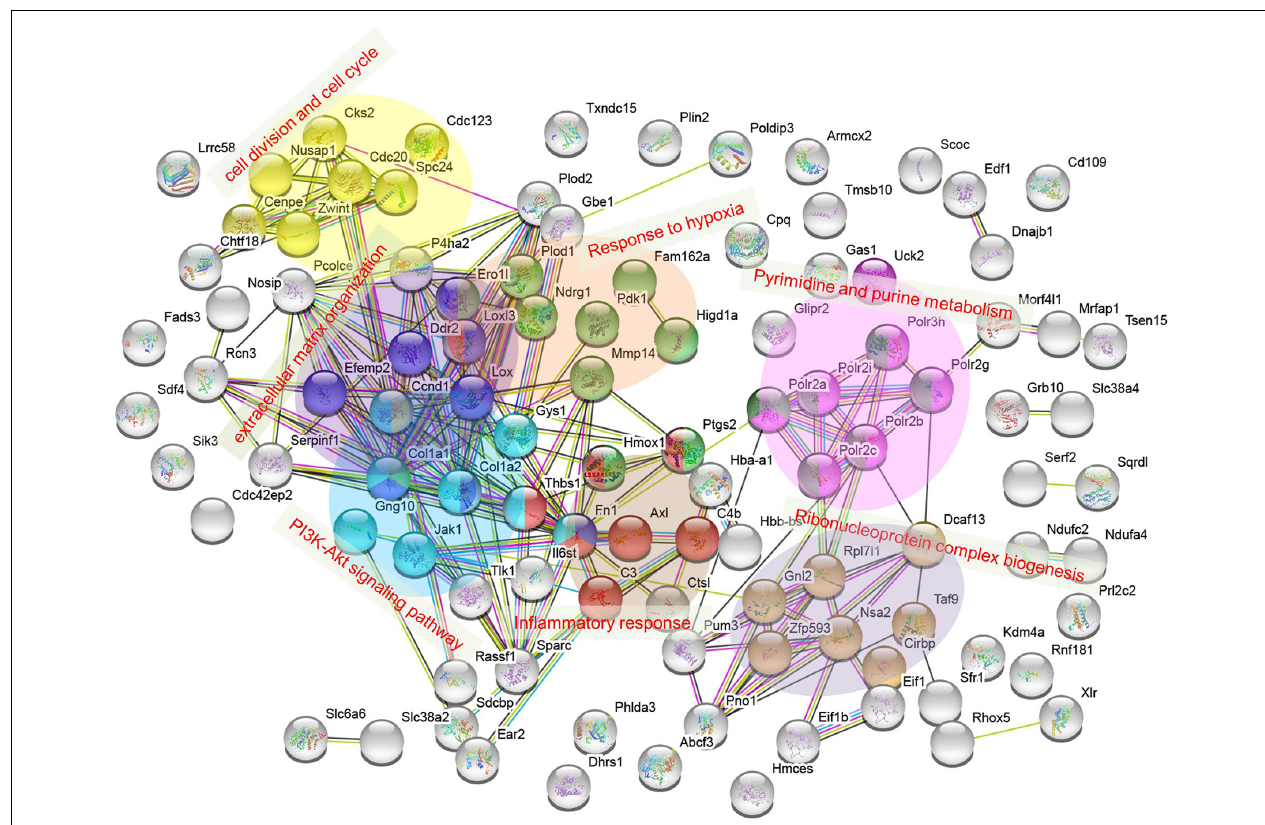
FIGURE 11 | Protein interaction network for 105 DAPs listed in Supplementary Table S9 . The interaction network was obtained using the STRING database http://string-db.org/ with a PPI enrichment p < 1.0 × 10 − 16 . Clustered proteins were indicated by different colors. Categories of pyrimidine and purine metabolism and PI3K-Akt signaling pathway were assigned from functional KEGG pathway analysis, while extracellular matrix organization, inflammatory response, cell division, and cell cycle, and ribonucleoprotein complex biogenesis were from GO term